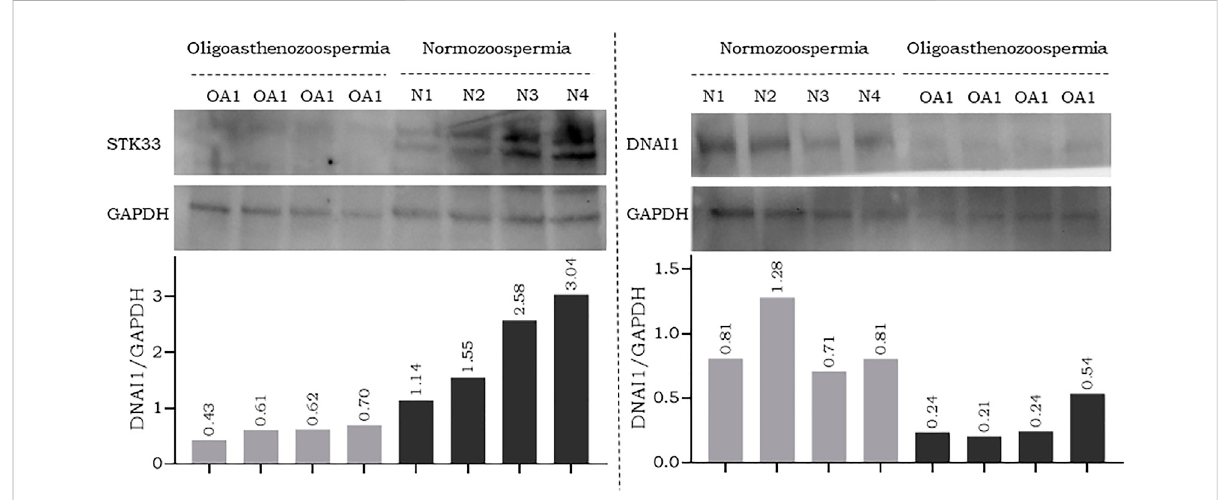
FIGURE 2 Western blot analysis and quanti fi cation of fl agellar and cilia assembly proteins STK33 (approximately 58 kDa), DNAI1 (approximately 79 kDa), and the endogenous control GAPDH (approximately 37 kDa) in semen samples collected from men with oligoasthenozoospermia (OA) and normozoospermia (N).